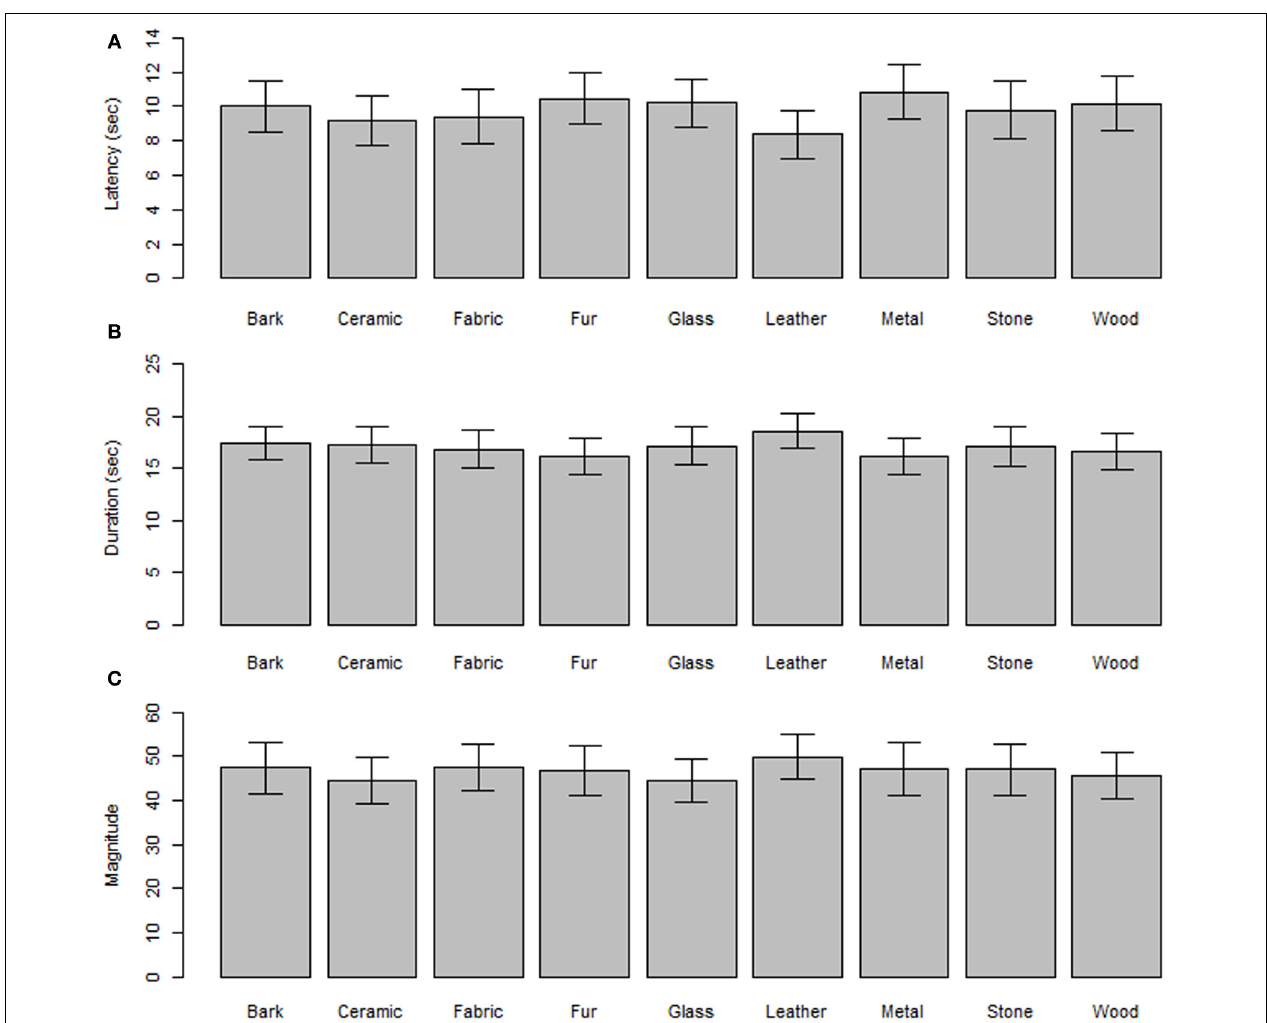
FIGURE 2 | Three measures of vection as a function of nine material category conditions. (A) The latency of vection induction. (B) The duration of vection. (C) The estimated magnitude of